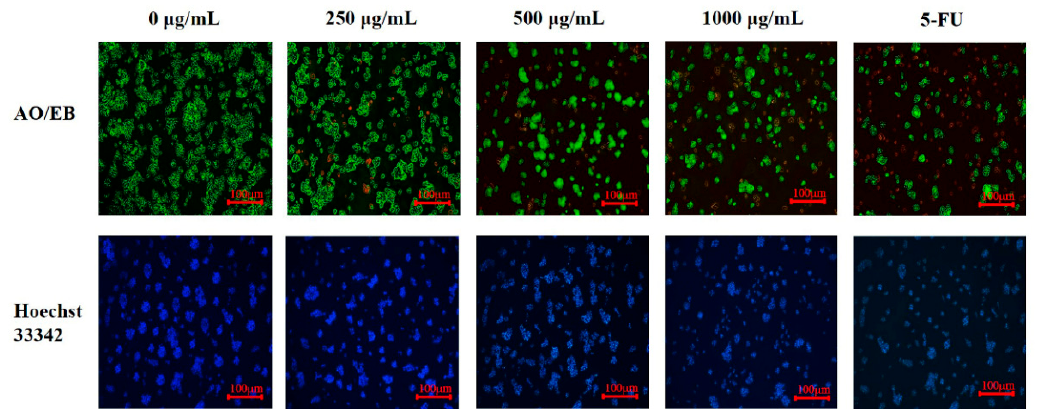
Figure 6. Effect of PED on the cell morphology of HepG2 cells.